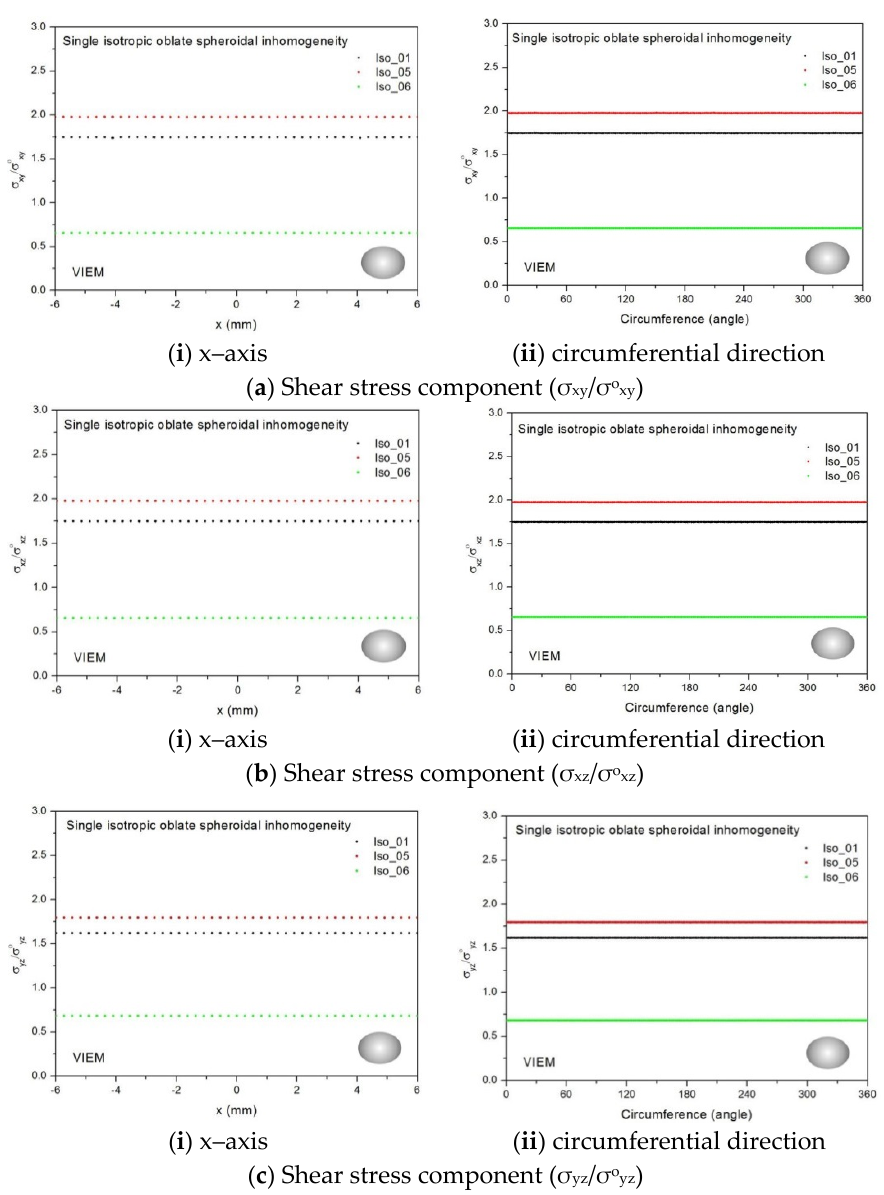
Figure 30. VIEM results for the normalized shear stress components ( a ) σ xy / σ oxy , ( b ) σ xz / σ oxz and ( c ) σ yz / σ oyz along ( i ) the x–axis inside and ( ii ) the circumferential direction of the isotropic oblate spheroidal inclusions (Iso_01, Iso_05 and Iso_06) with b/a = c/a = 0.75 (a = 6 mm) under remote shear loading ( σ oxy , σ oxz and σ oyz ).